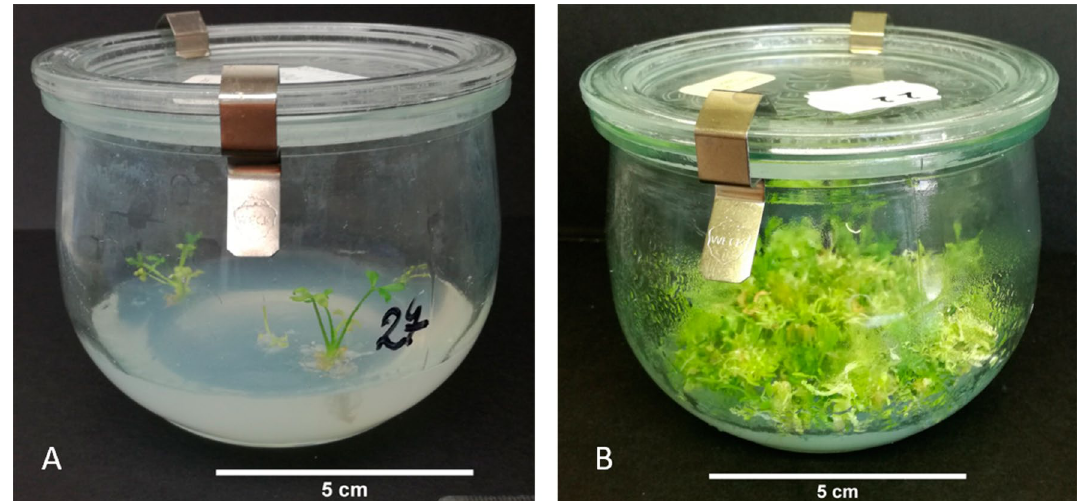
Figure 3. Type of samples used for molecular characterization. ( A ) Rooting plants were pooled by 5 per sample; ( B ) very tiny plants that were not rooting and were growing in bundles were pooled per jar, (microplant samples). The scale bar is 5 cm.